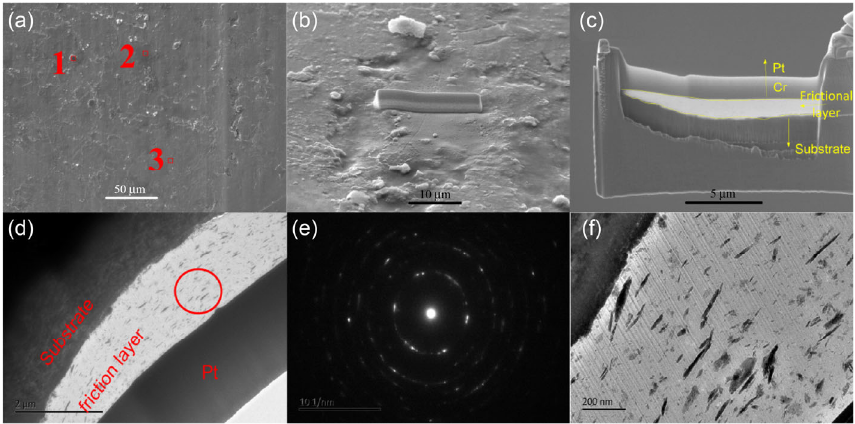
Fig. 21 SEM and TEM images of worn surfaces on ball lubricated with BP-16C at 75 mg/L: (a) SEM images of worn surfaces on ball; (b) the sampling place of samples using FIB; (c) TEM specimens by preparing in FIB; (d) TEM images of worn surfaces; (e) the selected area electron diffraction (SAED) images in the circle of (d); (f) TEM images of frictional